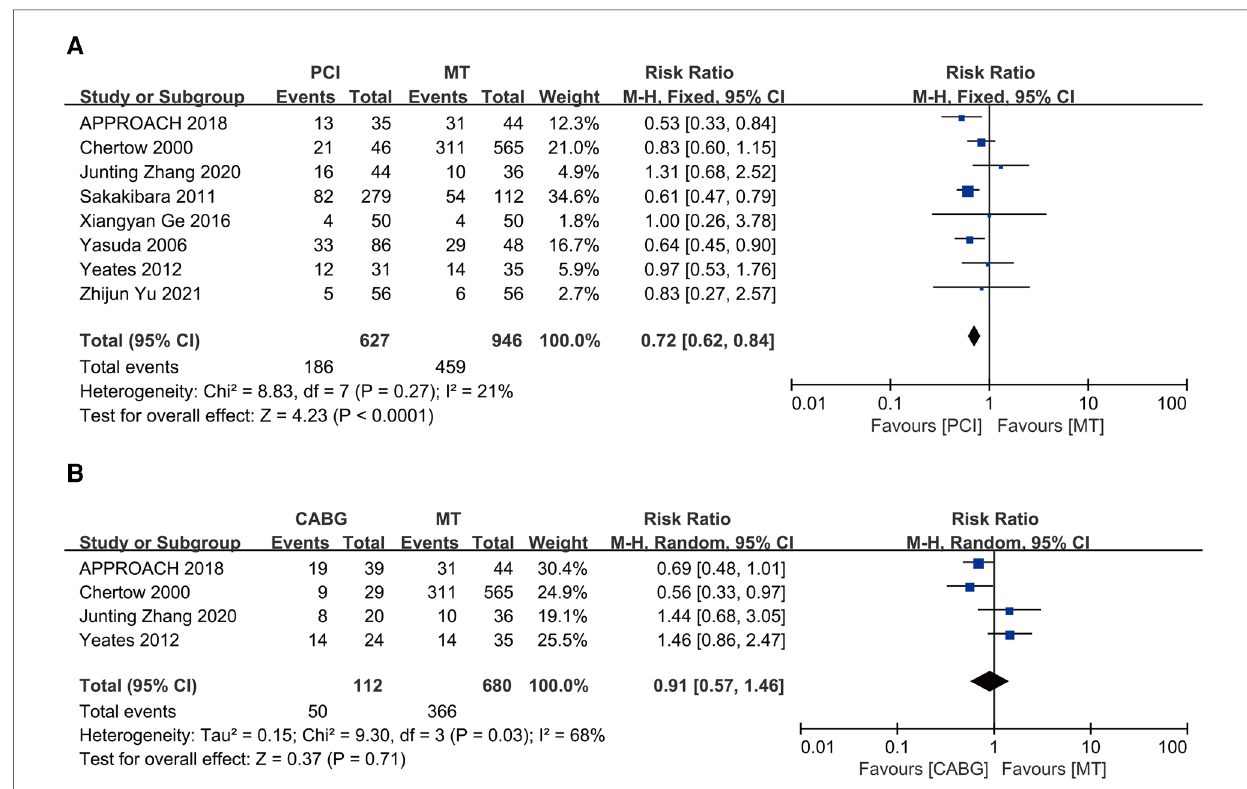
FIGURE 5 Long-term all-cause death: ( A ) PCI vs. MT; ( B ) CABG vs. MT; CABG, coronary artery bypass grafting; CI, con fi dence interval; MT, medical therapy; PCI, percutaneous coronary